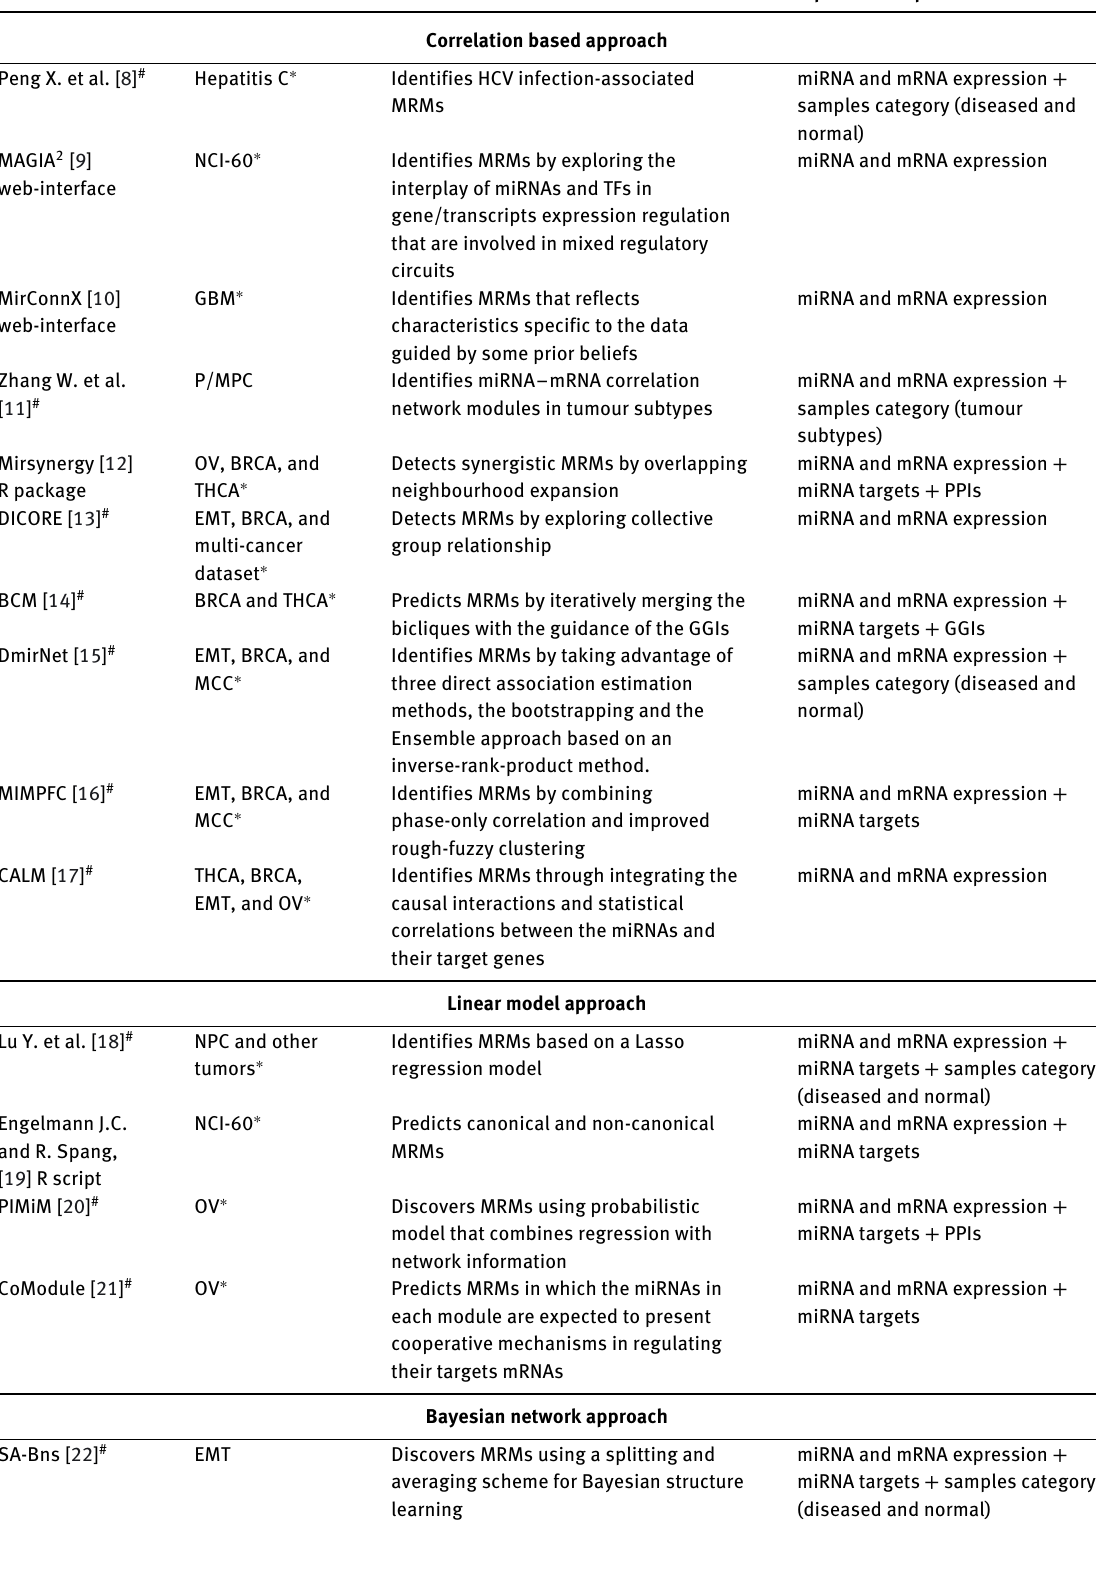
Table 1: List of algorithms/methods/approaches/tools for MRMs identification.